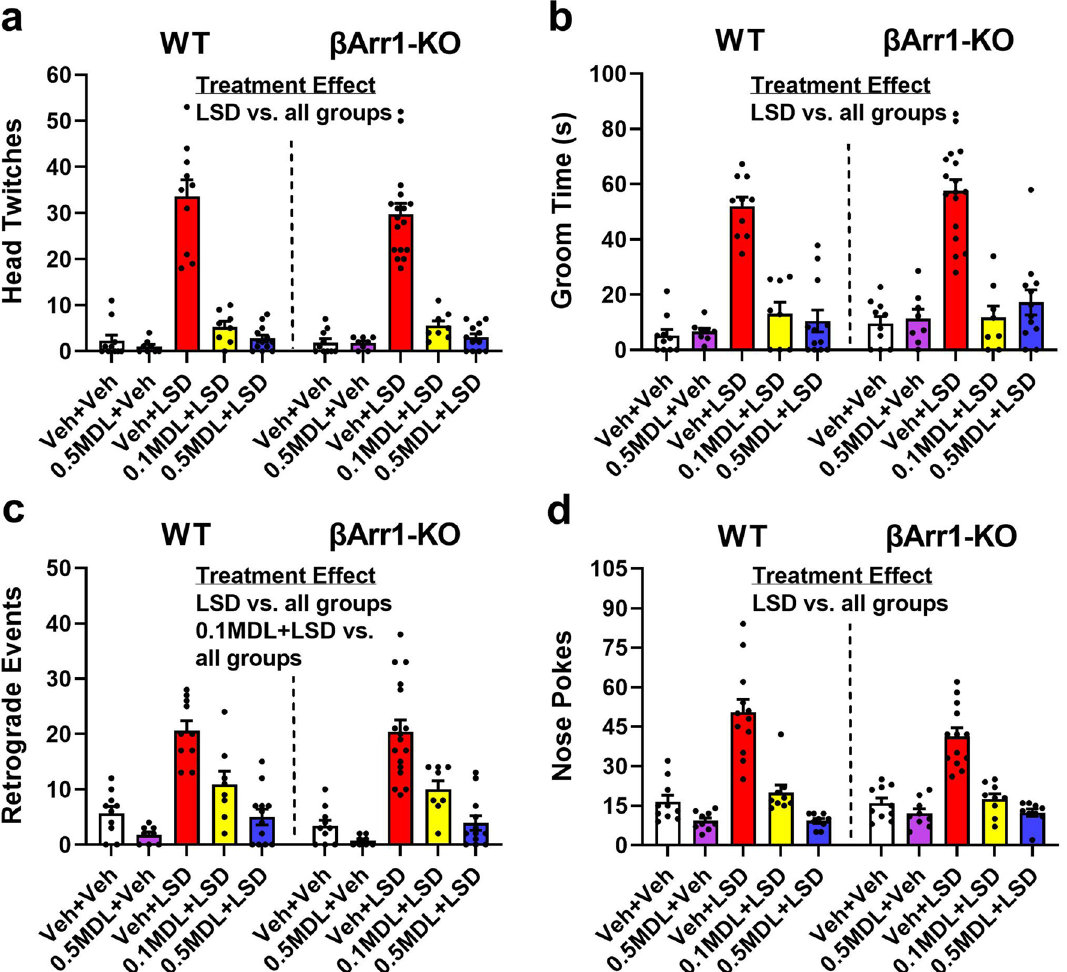
Figure 3. Effects of LSD and MDL100907 on behavioral responses in β-arrestin 1 mice. A description of the experimental design is shown in the Fig. 1 legend. The head twitch, grooming, and retrograde walking results represent the first 30 min after injection of LSD in the open field. Nose poking was examined in a 5-choice serial reaction time apparatus (no rewards) with a similar time-course for the vehicle and MDL injections as in the open field, followed by administration of the vehicle and LSD. ( a ) LSD-stimulated head twitches in WT and βArr1-KO mice. A two-way ANOVA revealed a significant treatment effect [F(4,93) = 114.447, p < 0.001]. ( b ) LSD-stimulated grooming in βArr1 animals. A two-way ANOVA identified a significant treatment effect [F(4,93) = 61.232, p < 0.001]. ( c ) LSD-stimulated retrograde walking in βArr1 subjects. A two-way ANOVA found the main effect of treatment to be significant [F(4,93) = 43.899, p < 0.001]. ( d ) LSD-stimulated nose poking in WT and βArr1-KO mice. A two-way ANOVA observed a significant treatment effect [F(4,89) = 60.656, p < 0.001]. N = 8–17 mice/group for head twitch, grooming, and retrograde walking; N = 9–13 mice/group for nose-poking. Bonferroni corrected post-hoc tests for head twitch, grooming, retrograde walking, and nose- poking responses for treatment effects: p < 0.001, LSD vs. all groups; for retrograde walking for treatment effects: p < 0.05, 0.1MDL + LSD vs. all